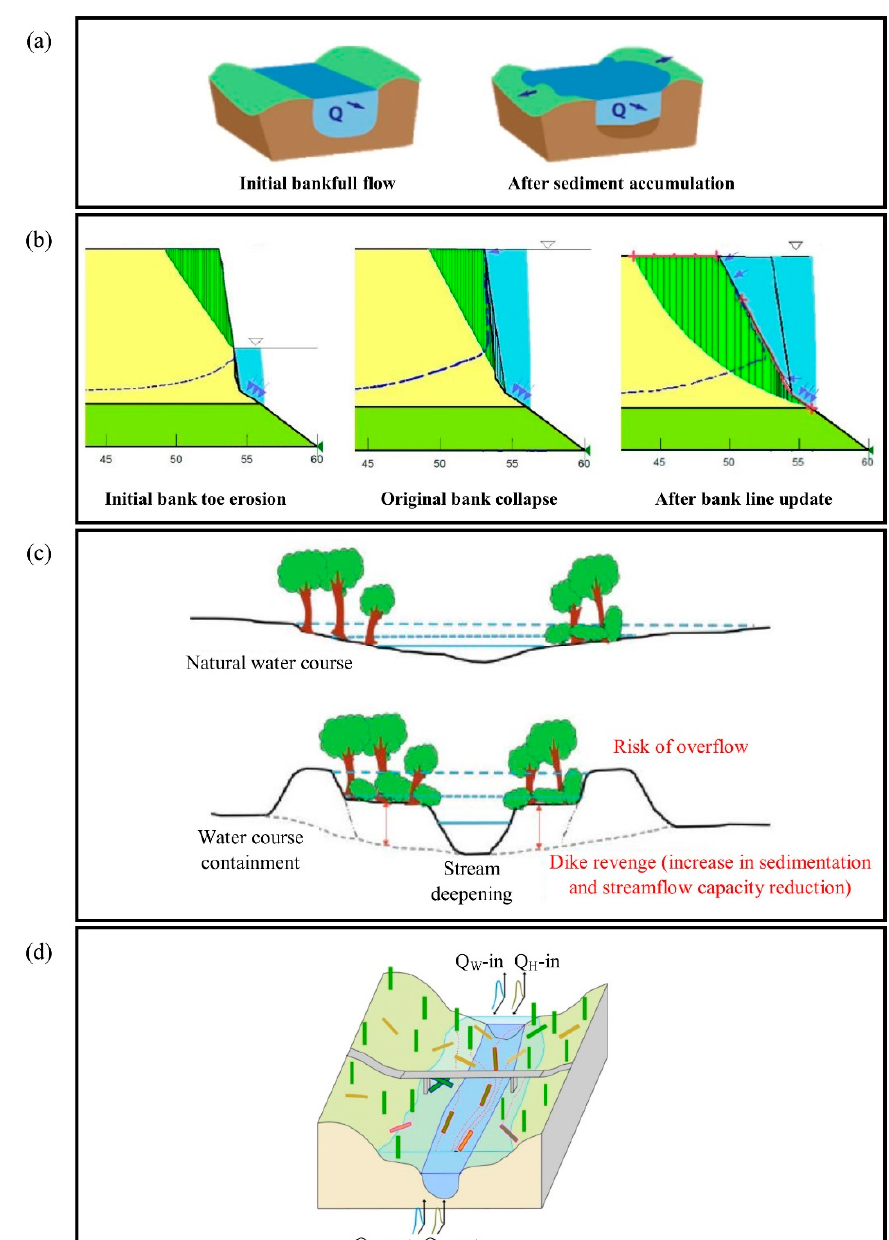
Figure 1. Some examples, taken from recent literature, of schematic representations of the interaction of deposition, erosion and transport processes with hydrological processes in induced flood phenomenon. ( a ) Sediment accumulation in the riverbed determines flooding. From “Modeling of HydroGeomorphic Hazards” project, University of Washington (http://notesbyshelby.blogspot.com/2018/12/quarter-1.html, last accessed on 26 June 2020). ( b ) Results from a numerical model simulation showing the erosion of a bank toe, affected by increasing river water level and a decreasing stability factor, causes bank collapse and riverbank state recovery after bank line update (from left to right of the box). From [44], Figure 14 (slightly modified). ( c ) Graphic illustrating schematically the role of the riparian vegetation in watercourses, and its effects on the speed and capacity of streamflow, leading to increased risk of overflow. From [45], Figure 10 (slightly adapted). ( d ) Schematic illustration of the transport of large wood debris and its accumulation (log-jam), creating local obstructions leading to flooding, especially at bridge locations. From [46], graphical abstract (slightly adapted).